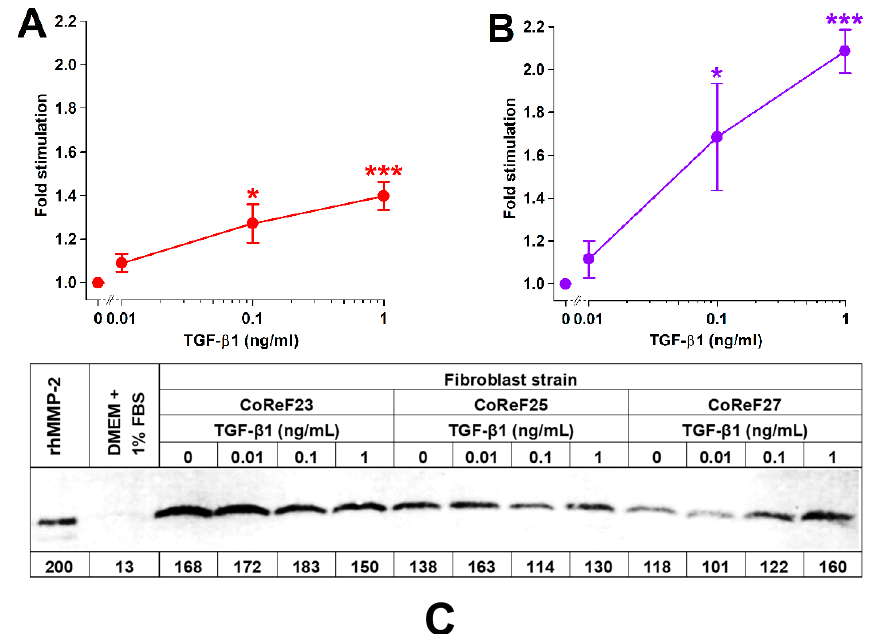
Figure 8. Effect of TGF- β 1 on collagen deposition ( A ), cell numbers ( B ), and MMP-2 ( C ) of CoReFs treated for 8 days at three different concentrations (0 [control], 0.01, 0.1 and 1 ng/mL). ( A , B ) Mean ± SEM ( n = 6). * p < 0.05, *** p < 0.001 vs. control. ( C ) A representative zymogram (inverse image) of MMP-2 in the conditioned media (5 µL/lane) from CoReFs (3 patients). The estimated MMP-2 content (pg) is indicated below each lane of the zymogram from the densitometric determination of band intensities by ImageJ.